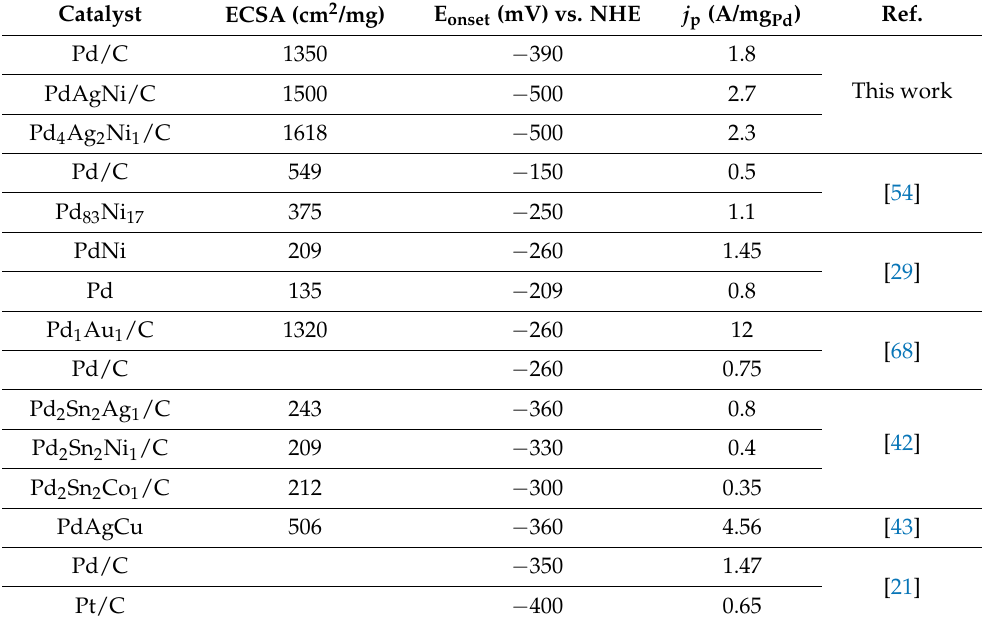
Table 4. Comparison of the ECSA (cm 2 /mg), E onset (mV) and j p (A/mg Pd ) in 1M EtOH of this work and previously published catalysts. Catalyst ECSA (cm 2 /mg) E onset (mV) vs. NHE j p (A/mg Pd )